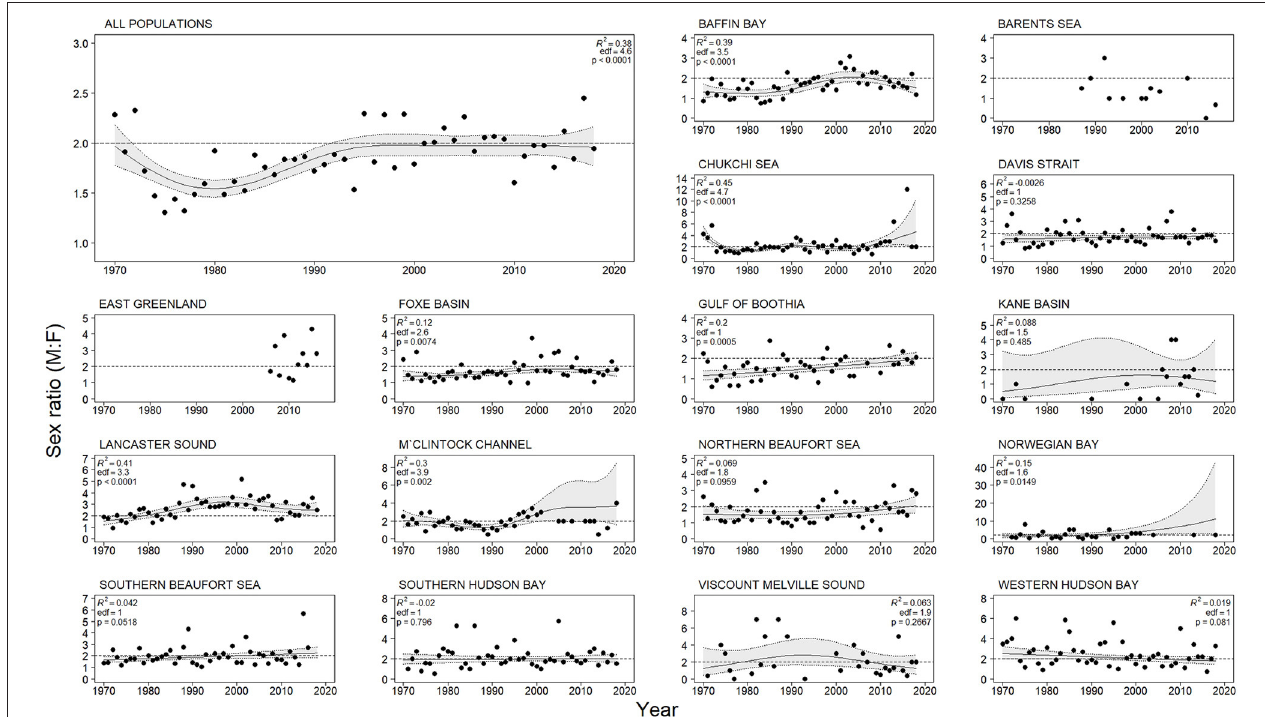
FIGURE 3 | Sex ratio of all harvested bears of known sex (large panel top left), and in harvest for 16 of 19 polar bear populations (small panels), in the period 1970–2018. Dotted horizontal line represents the 2M:1F sex ratio, and gray bands indicate the 95% confidence intervals. Trend lines are fitted with a Generalized Additive Model (GAM, k = 6). Trend lines not shown for Barents Sea and East Greenland populations due to data not covering the entire